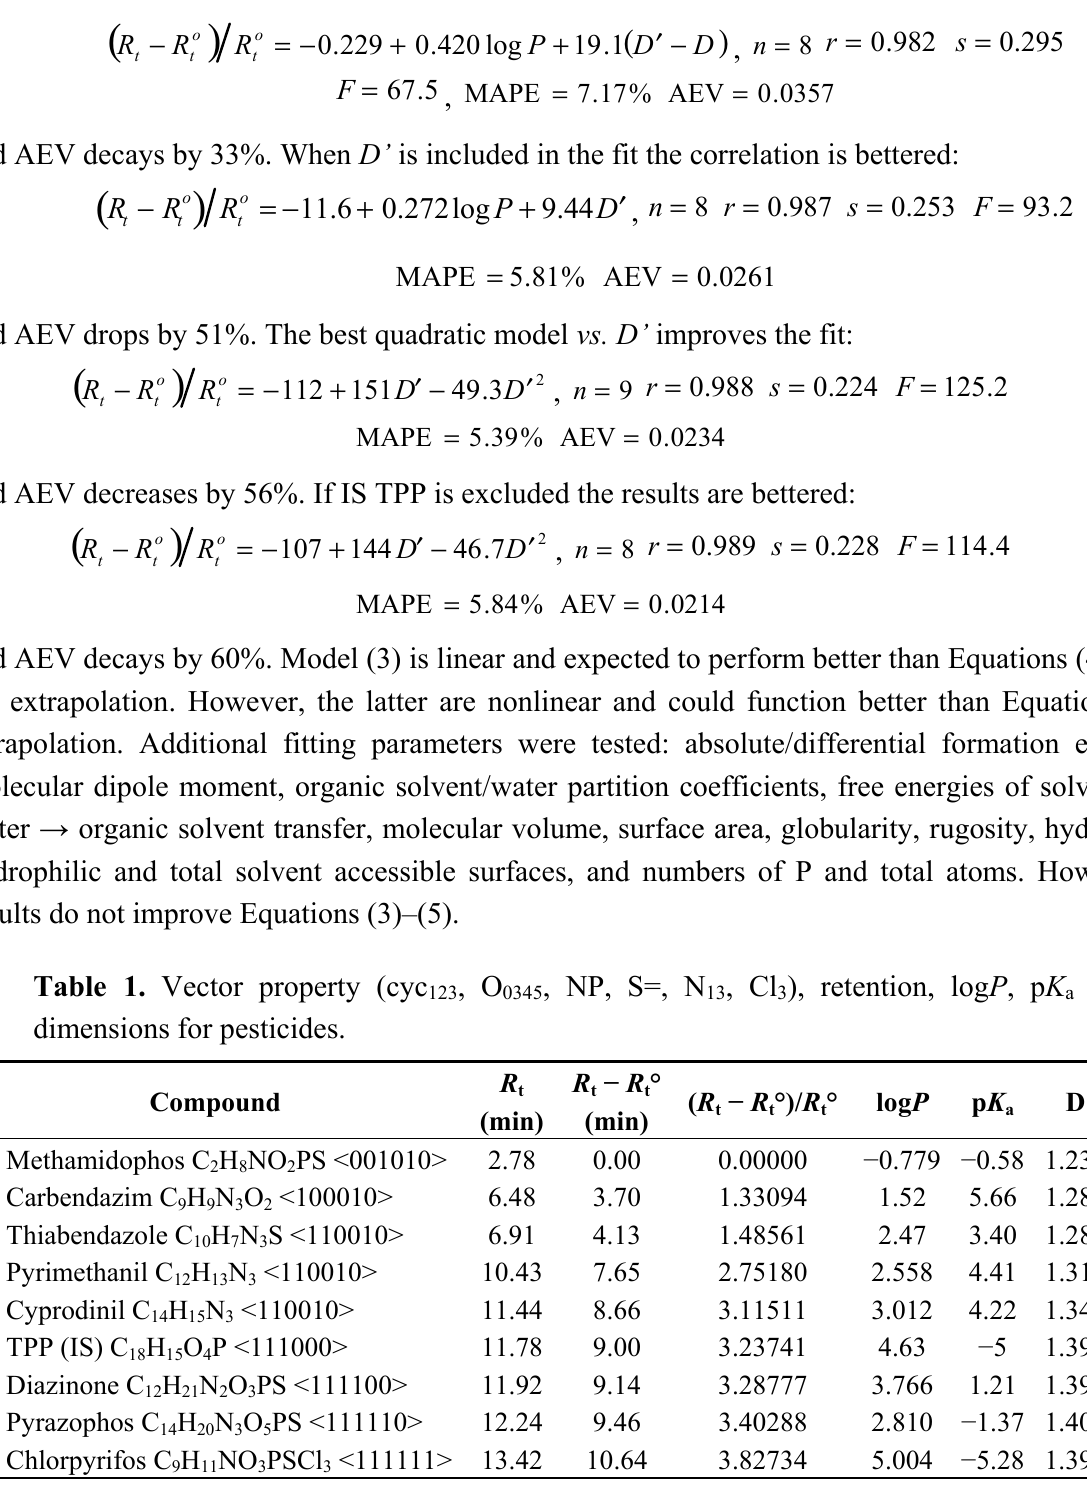
, Cl ), retention, log P , p K 13 3